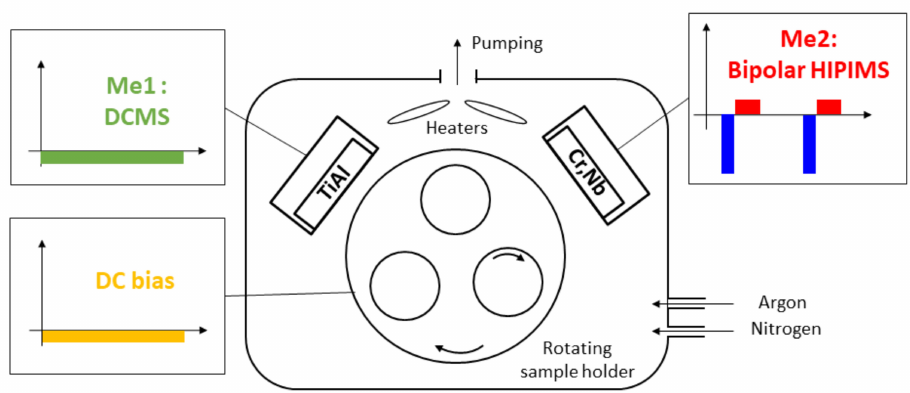
Figure 2. Schematics configuration of the industrial batch